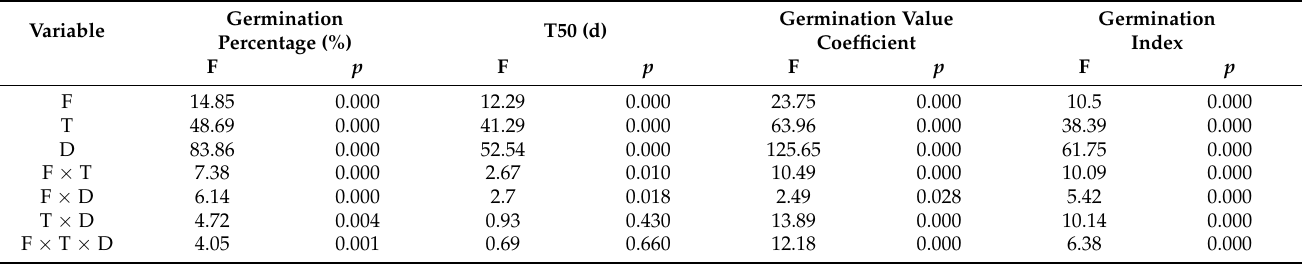
Table 2. Three-way ANOVA on the effects of family (F), temperature (T), drought (D) and the interaction on seed germination. of Betula platyphyll